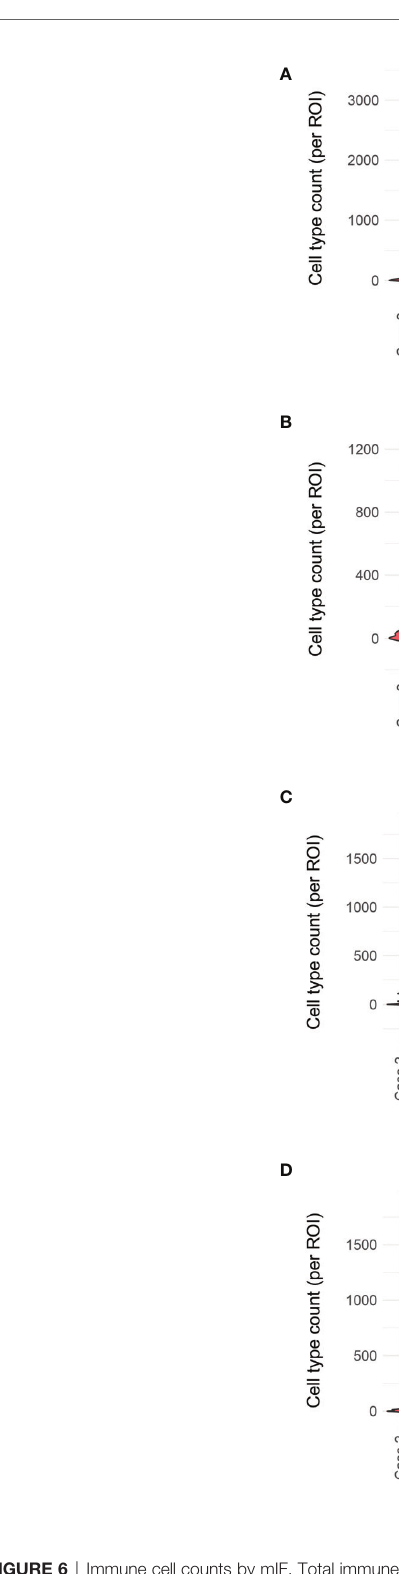
FIGURE 6 | Immune cell counts by mIF. Total immune cell counts for metaplastic Cases 2, 4, and 5 plotted with non-metaplastic (cases identi fi ed as ‘ NM ’ ) TNBC from the same clinical trial in a violin plot. No clear difference is noted between the metaplastic cases and non-metaplastic cases (A) Helper T-cells (B) Cytotoxic T-cells (C) Macrophages (D) Regulatory